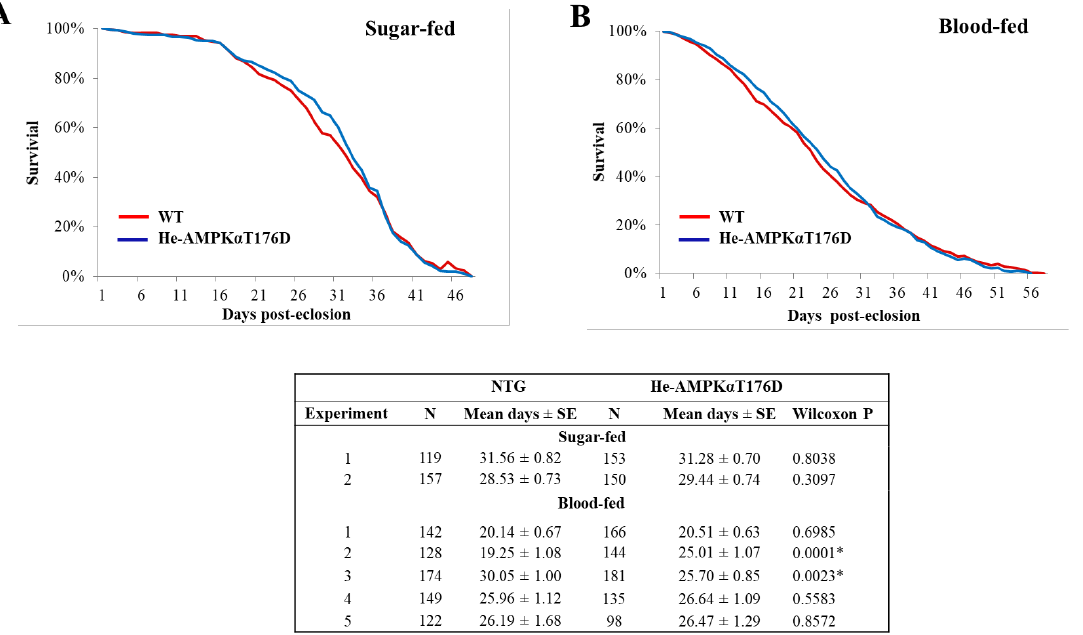
Figure 4. Survivorship of sugar-fed and blood-fed AMPK α T176D hemizygous transgenic (TG) and non-transgenic (NTG) An. stephensi . ( A ) A representative survivorship curve comparing hemizygous TG and NTG siblings reared under identical conditions and provided with 10% sucrose ad libitum . Lifespan experiments were replicated twice with independent cohorts of mosquitoes. ( B ) A representative survivorship curve comparing hemizygous TG and NTG siblings reared under identical conditions and provided with a daily bloodmeal and 10% sucrose solution. Lifespan experiments were replicated five times with independent cohorts of mosquitoes. The table summarizes the sample sizes, means, and statistical analyses results (* p<0.05) of lifespan data using the Wilcoxon test for sugar-fed and blood-fed mosquitoes.